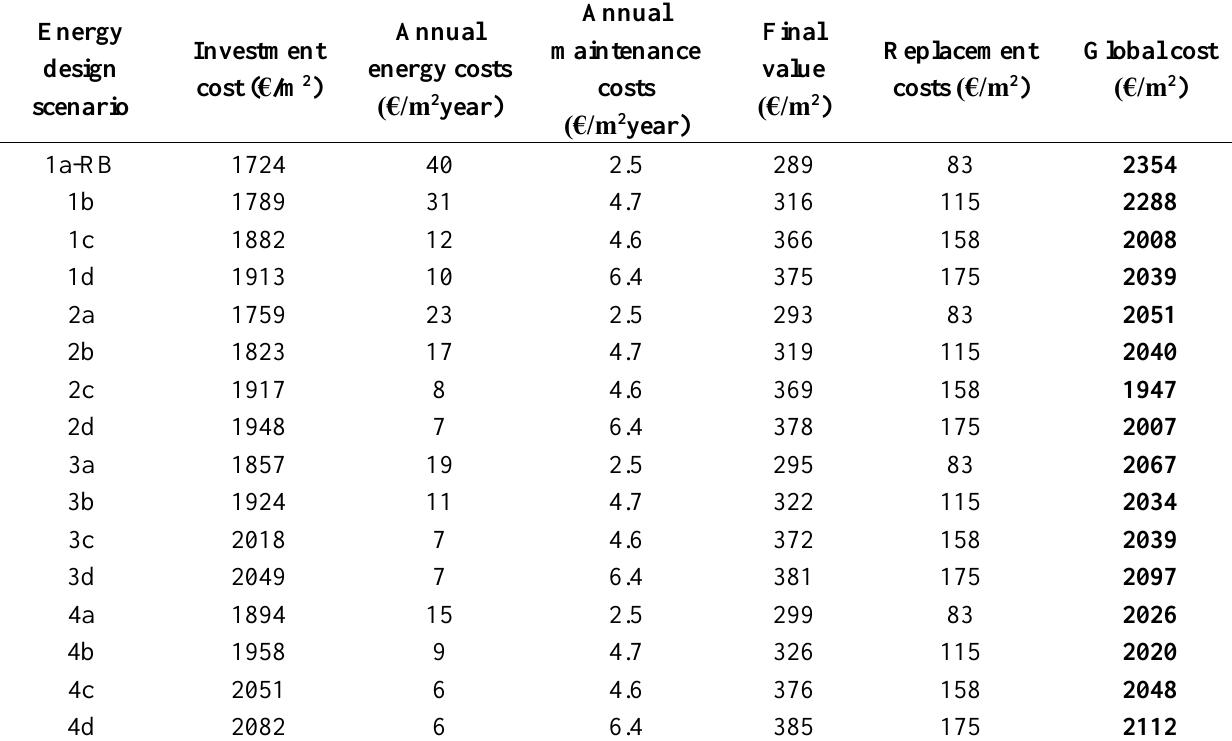
Table 3. Numerical results for the global cost calculation over 30 years. RB: reference